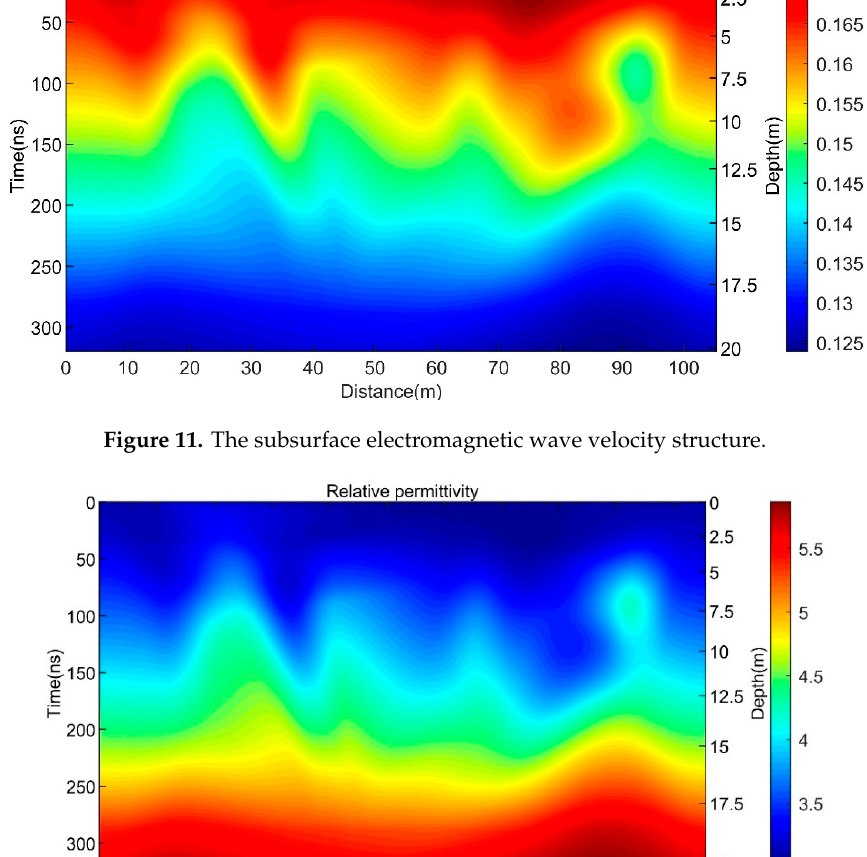
Figure 13. The density structure of lunar regolith. Figure 14. The TiO 2 and FeO content of lunar regolith.